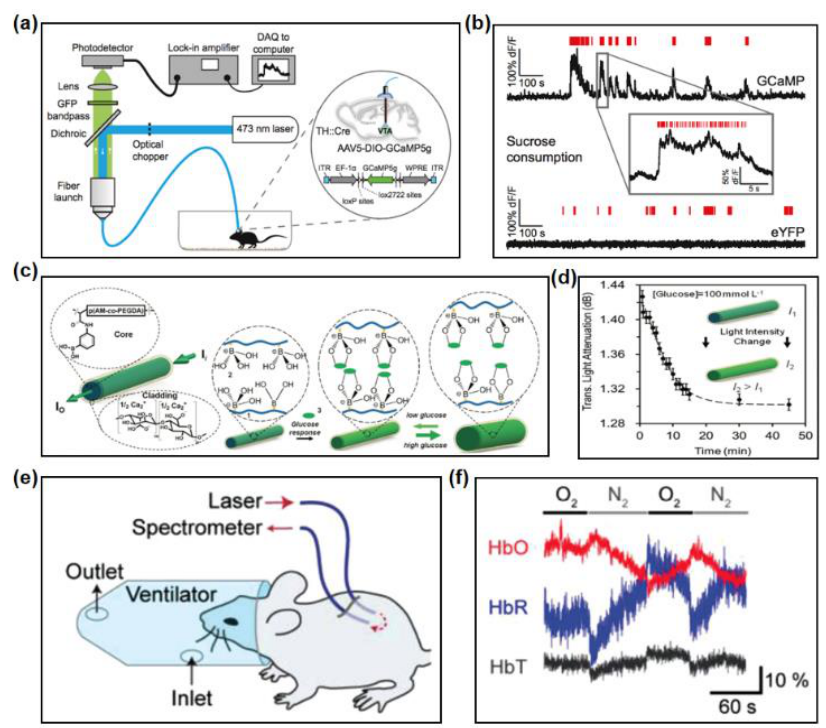
Figure 10. Fibers and waveguides in optical-sensing. ( a ) A scheme diagram of a fiber